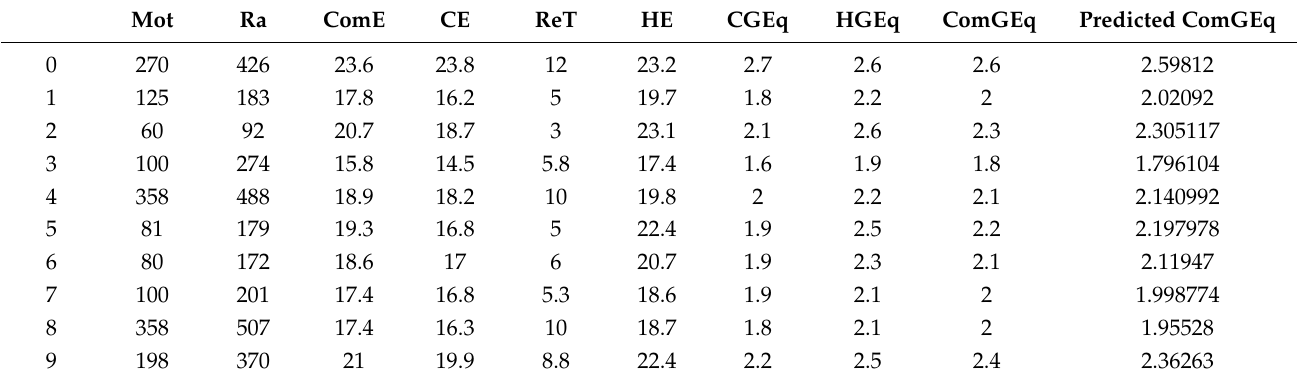
Table 8. Predicted and desired combined gasoline litre consumption equivalent.